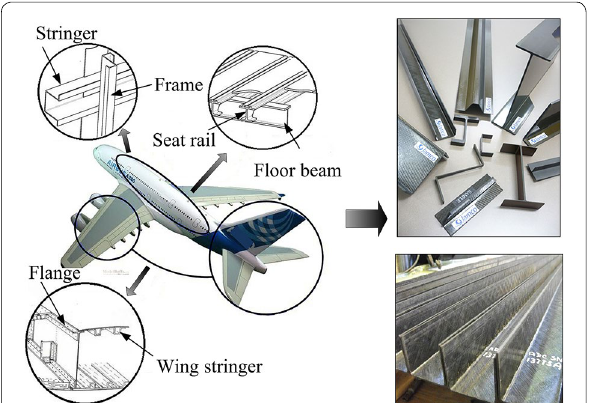
Figure 1 Al–Li alloy extrusion profiles can be used in